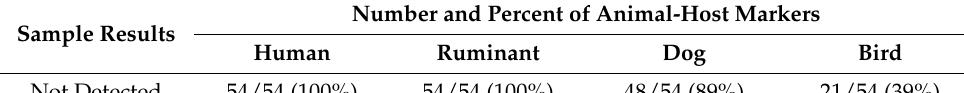
Table 1. Summary of animal–host microbial source tracking marker concentration measurements in samples collected at Clam Beach near Strawberry Creek (sites 2a and